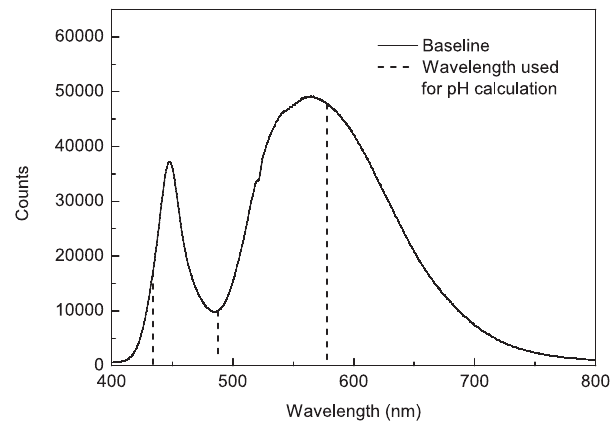
Fig. 4. Electrical counts of the emission spectrum of the ultra bright white LED taken with the CCD spectrometer during shipboard op- eration through seawater. The marked measurement wavelengths 434nm and 578nm are used for pH calculation and 487.6nm (isos- bestic point of mCP) is used for detection of the indicator dye con-